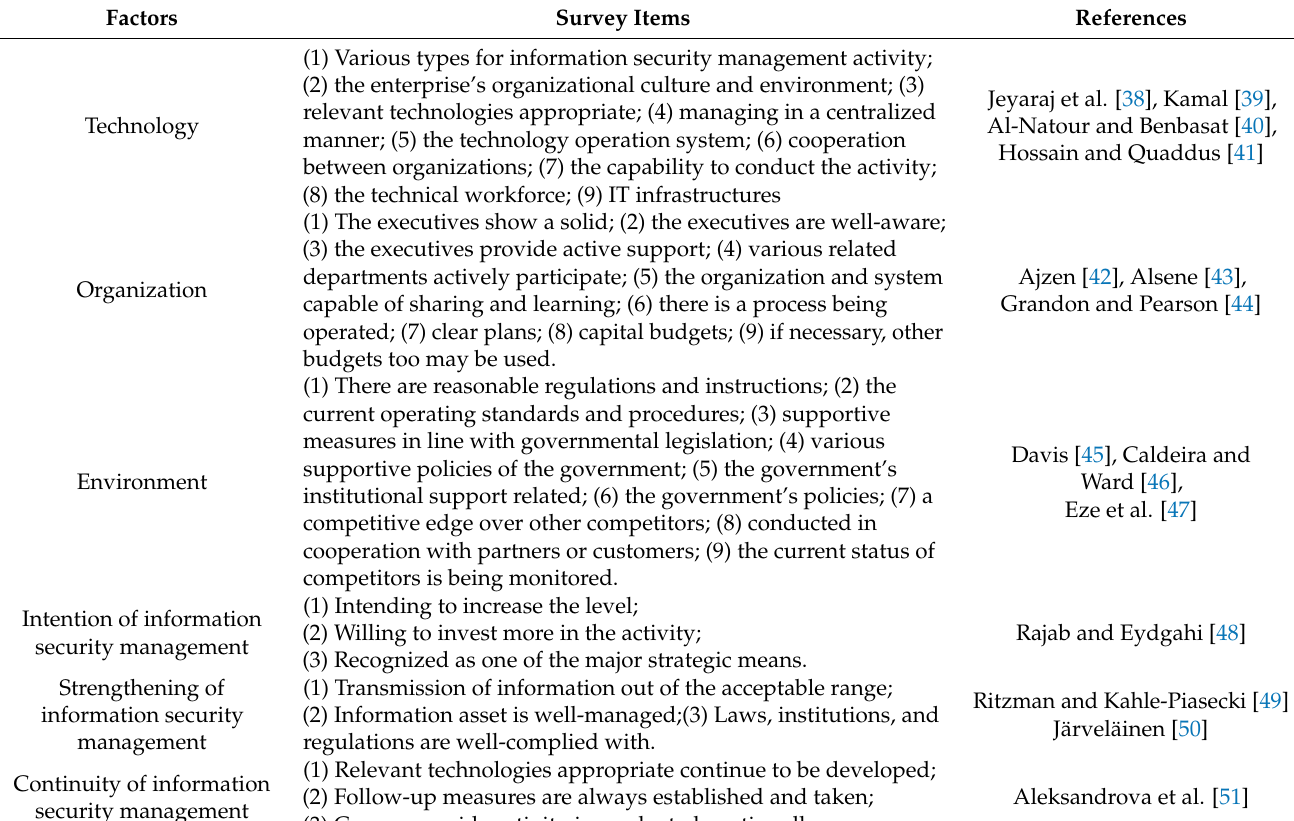
Table 1. Research variables and survey